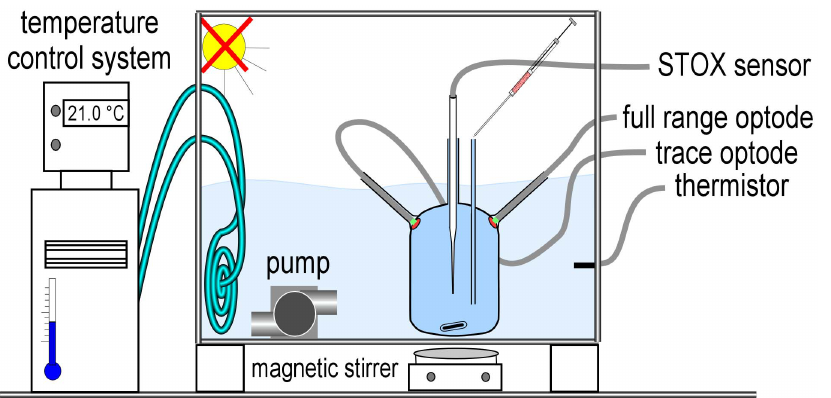
Figure 1. Incubation setup for Experiment 1. The incubation bottle was placed in a temperature controlled water bath. The 2 optodes (full range and trace) were placed on opposite sides in the upper half of the bottle. The STOX sensor was inserted through a glass tube in the center of the bottle. For calibration, known volumes of air saturated water were added through the pressure compensation port. A glass coated magnet was rotated by a magnetic stirrer below the container.